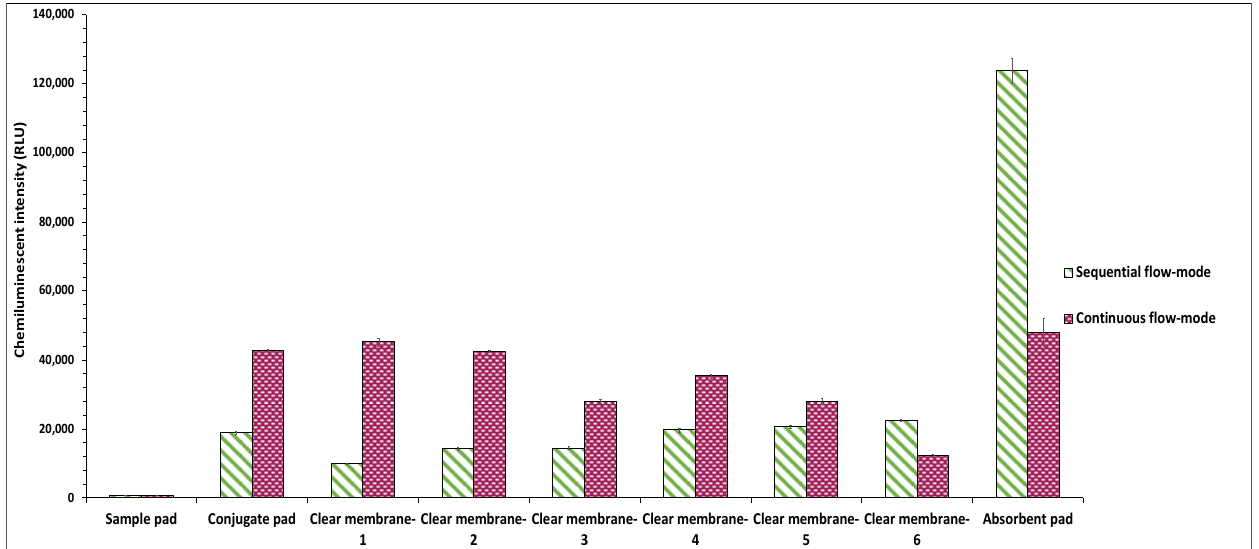
Figure 5. Effect of different types of sample addition modes on the conjugate release.